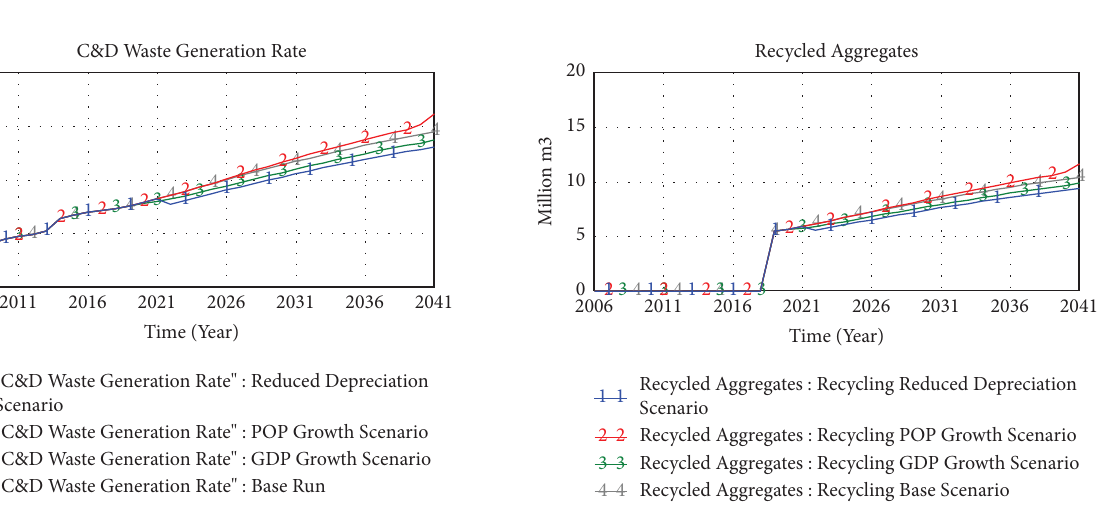
Figure 7: Te variable trend of recycled aggregates in the recycling option